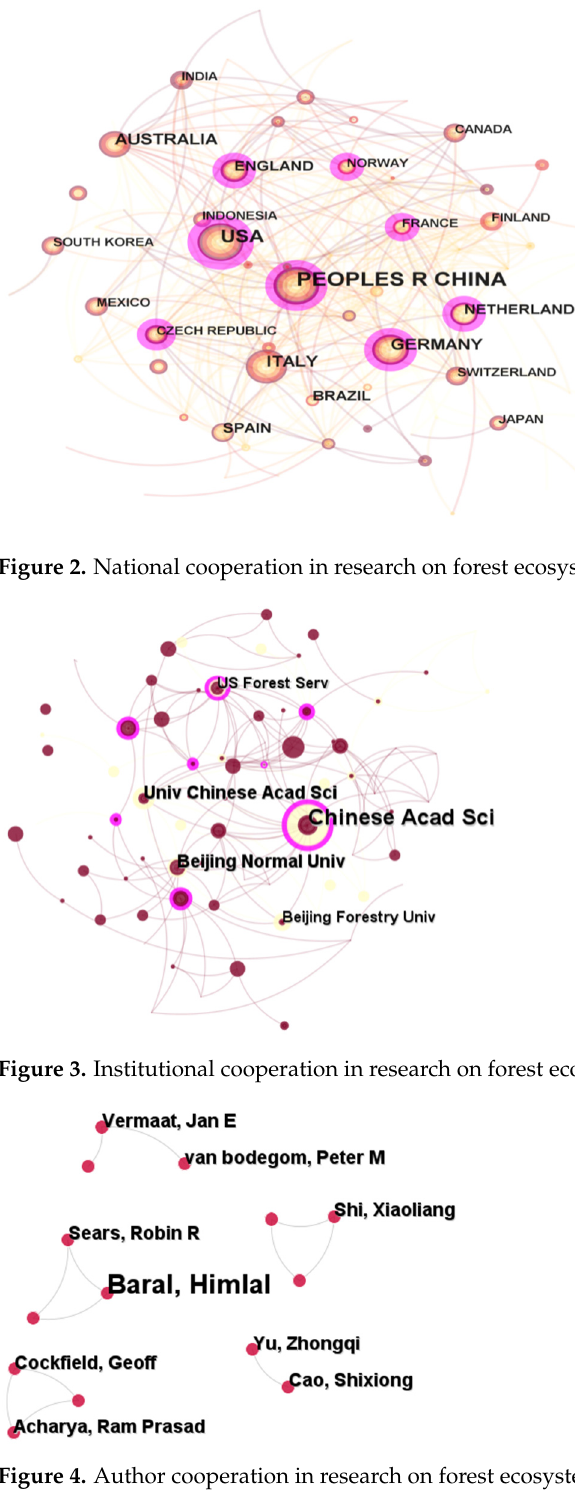
Figure 4. Author cooperation in research on forest ecosystem services among countries.